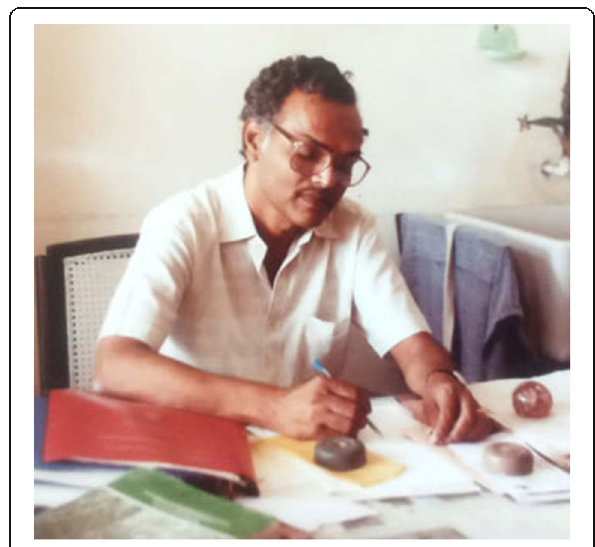
Fig. 32 Balumuri Pandu Ranga Vittal in his office in